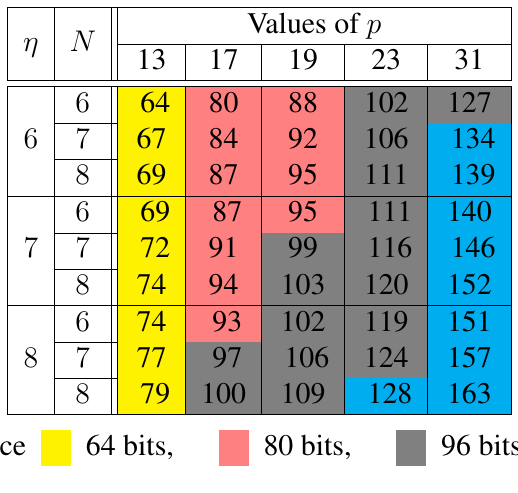
Table 1. Key space in